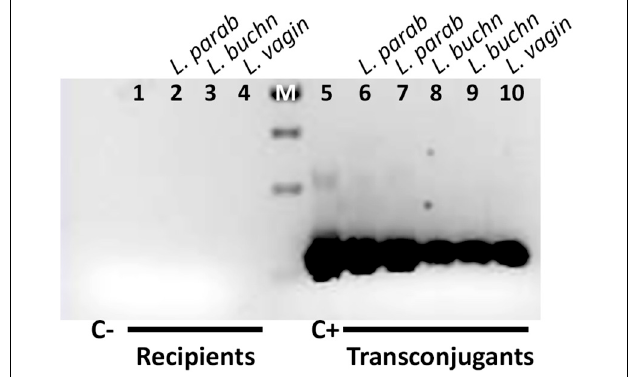
FIGURE 2 | Amplification of RP4 oriT from transconjugants. Primers used are shown in Table 3 . The template DNAs are: Lane 1: no DNA (C–, negative control). Lanes 2–4: gDNAs from recipient L. parabuchneri, L. buchneri and L. vaginalis. M, molecular marker (GeneRuler 1 kb DNA ladder). The size of the bands is 1,000, 750, 500, and 250 bp from top to bottom. The expected size of the amplicon is 280 bp. To the right, Lane 5: pCOR49 plasmid DNA (C+, positive control). Lanes 6 and 7: DNA extracts from L. parabuchneri transconjugants. Lanes 8 and 9: DNA extracts from L. buchneri transconjugants. Lane 10: gDNA extracts from L. vaginalis transconjugant.